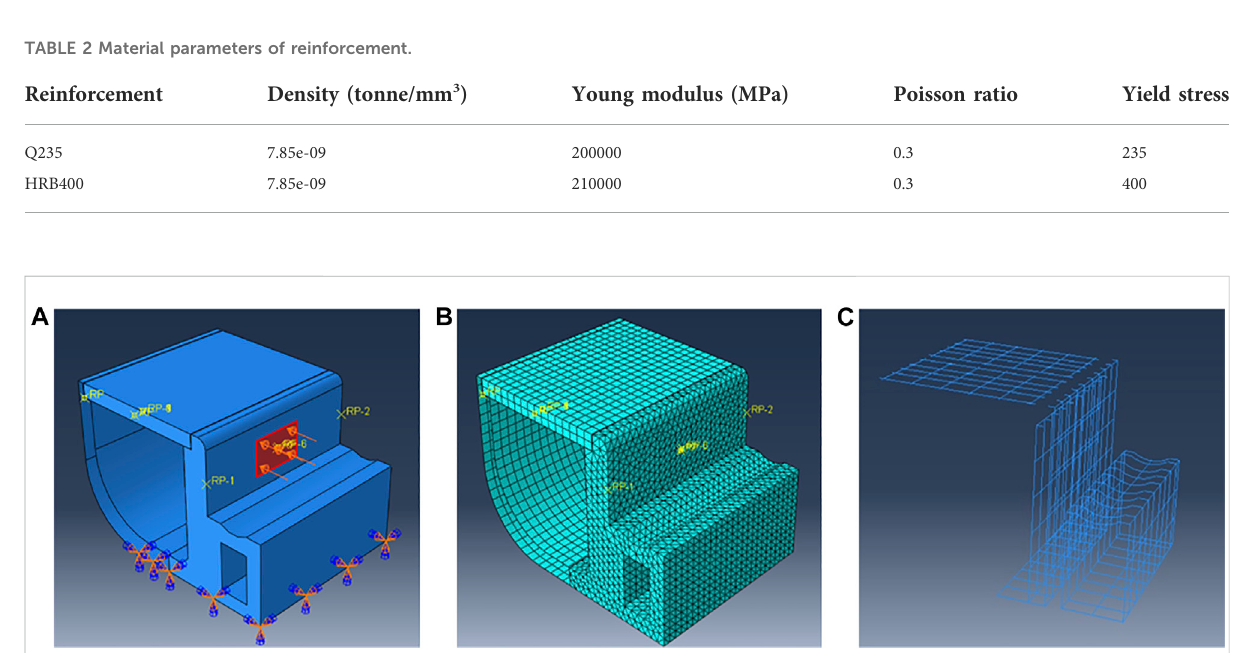
FIGURE 5 A geometrical model and fi nite element mesh of the curb component parts: (A) geometrical model, (B) fi nite element mesh, and (C)